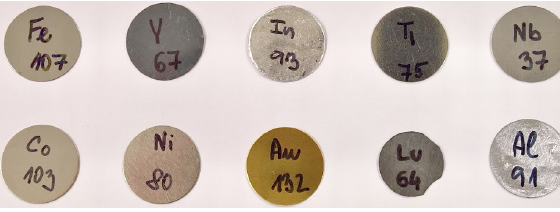
Table 2. Parameters of the extracted ions from the cyclotron U-120M [12].